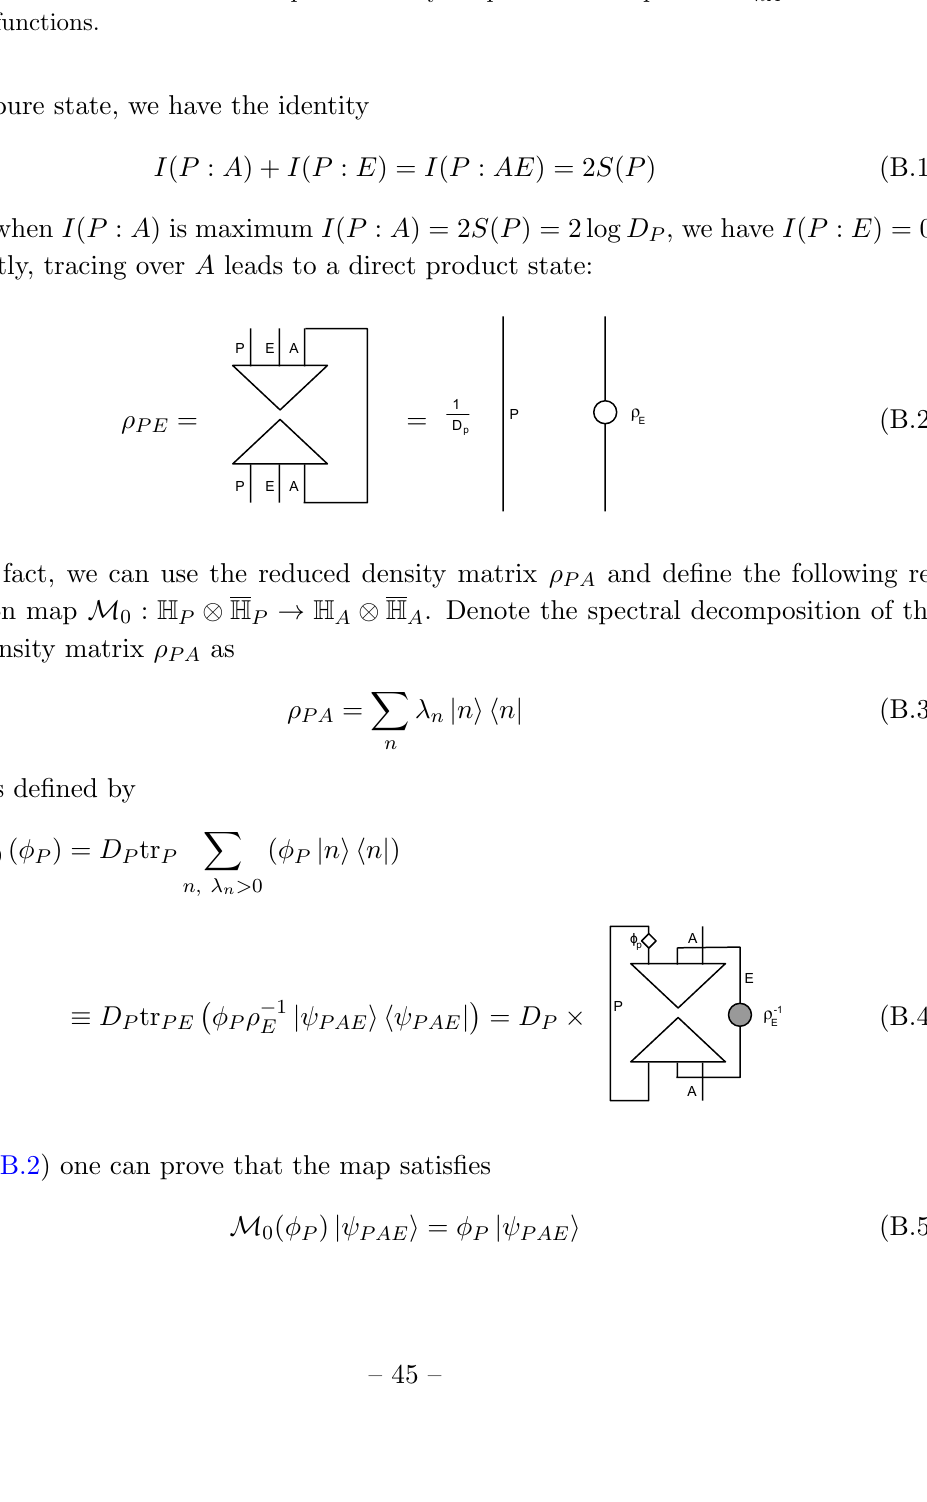
Figure 22. Illustration of the decomposition of cyclic permutation operator X nA into a sum of correlation